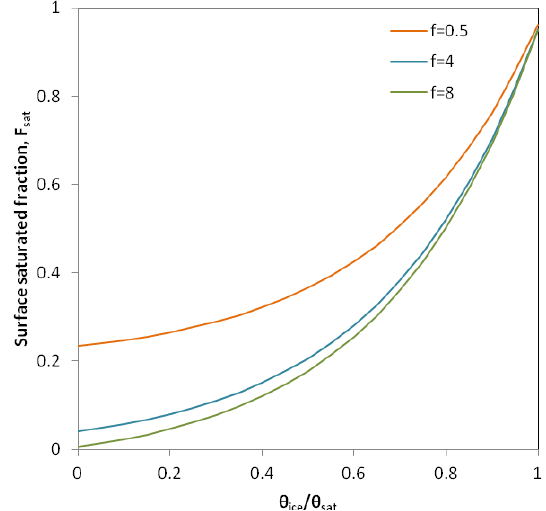
Fig. 1. Demonstrating the effect of α on the F frz function. The dot- ted line shows the actual frozen fraction of the soil, the coloured lines show the effective frozen fraction of Niu and Yang. The blue line uses the chosen model parameter while the orange and green lines use parameters that lie just outside the extremes of the selected parameter space.